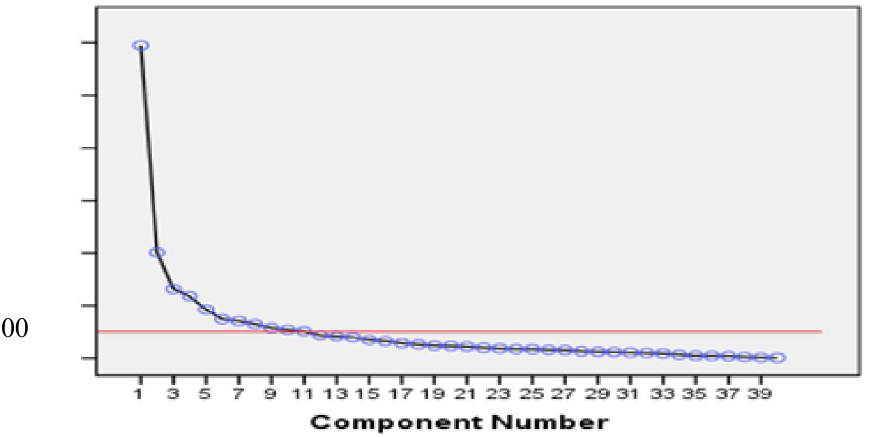
Fig. 1. The summary of Scree